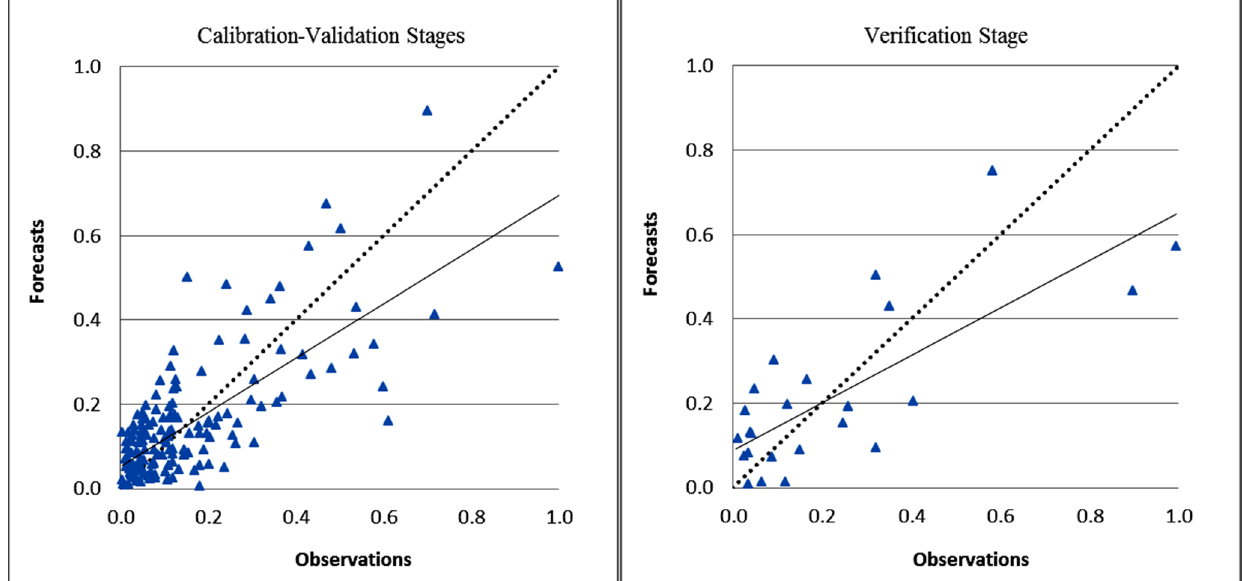
Figure 7. Final results of standardized forecasts vs. standardized observations using the SR